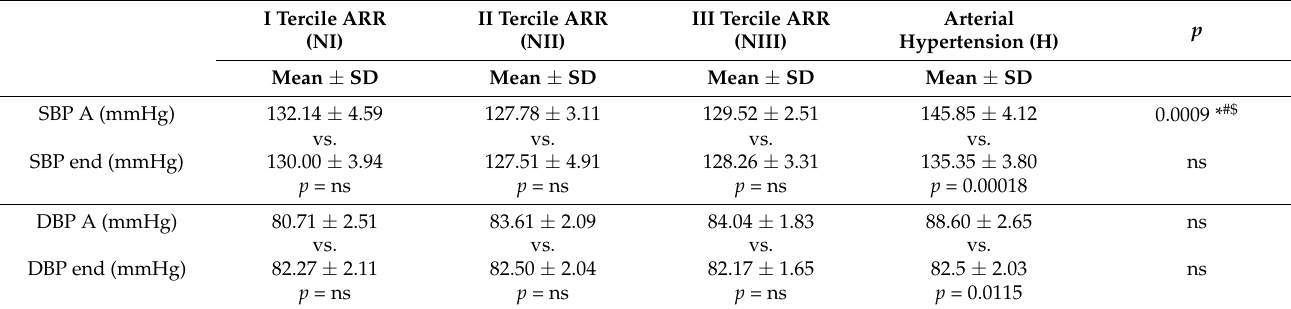
Table 2. Blood pressure measurements at the beginning and at the end of study protocol (for normotensives—A and B, for hypertensives A and